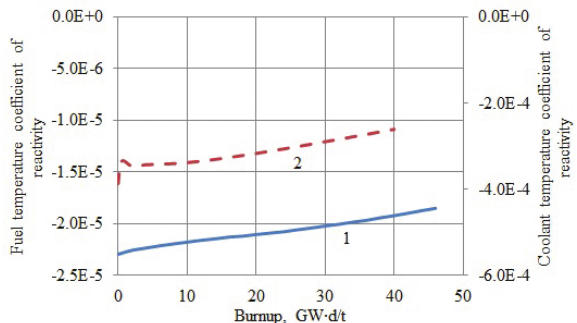
Figure 8. Changes in the reactivity coefficients for the fuel com- position containing 16% of 235 U + 74% of 238 U + 10% of 237 Np during the campaign: 1) fuel temperature coefficient of reactivi- ty; 2) coolant temperature coefficient of